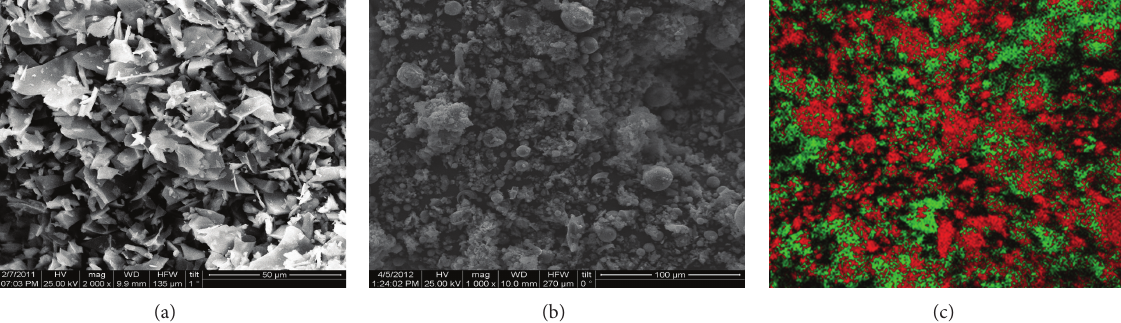
Figure 5: Scanning electron microscopy (SEM) micrographs of pure perlite (a), composite TiO 2 /perlite (b), and elemental mapping for the FSPD sample using energy dispersive spectroscopy (c). Red colour corresponds to Si and green to Ti.